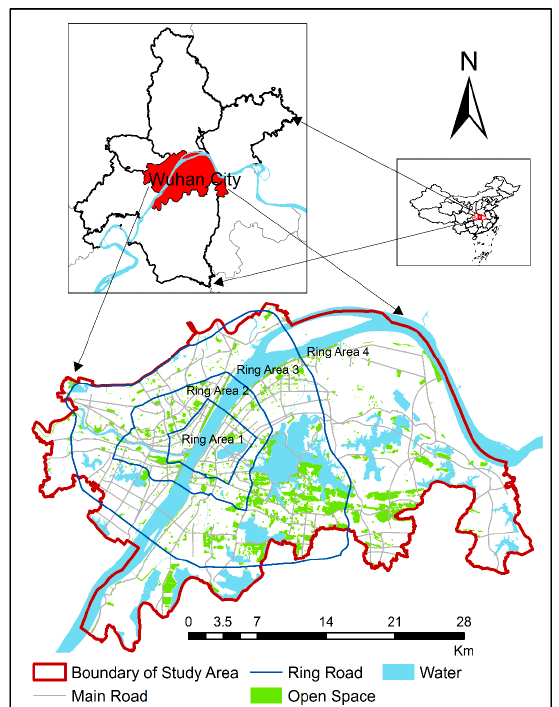
Figure 2. Case study area in the main part of Wuhan City in China with open spaces, water, four ring roads, and main roads.